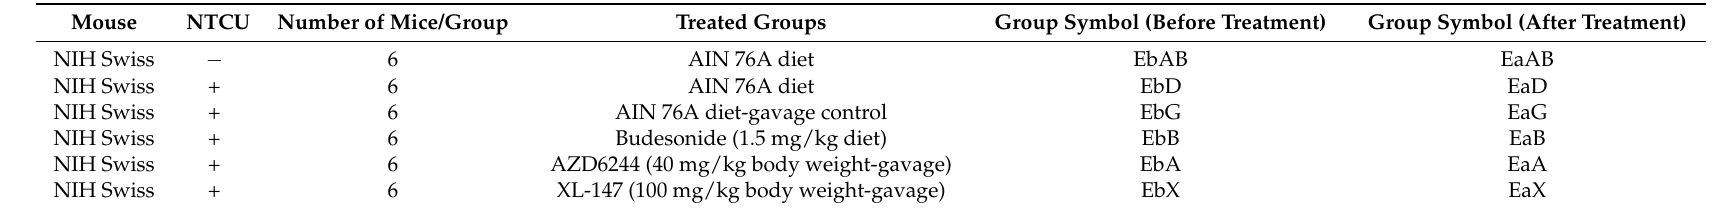
Table 1. Groups of mice with different chemopreventive agent treatments.